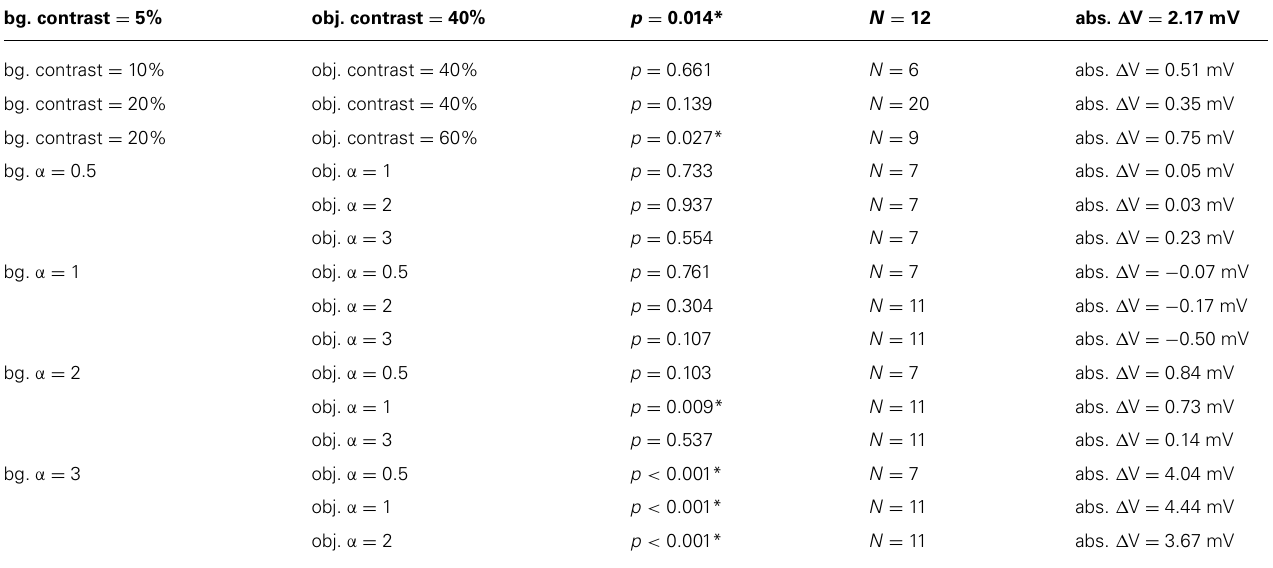
Table 1 | Results of two-sided t -tests for (cid:2) V (cid:2)= 0, asterisk marks significance ( p < 0.05), number N of recorded cells included in calculations and average object induced absolute difference in membrane depolarization without normalization (abs. (cid:2) V) for all combinations of background (bg.) and object